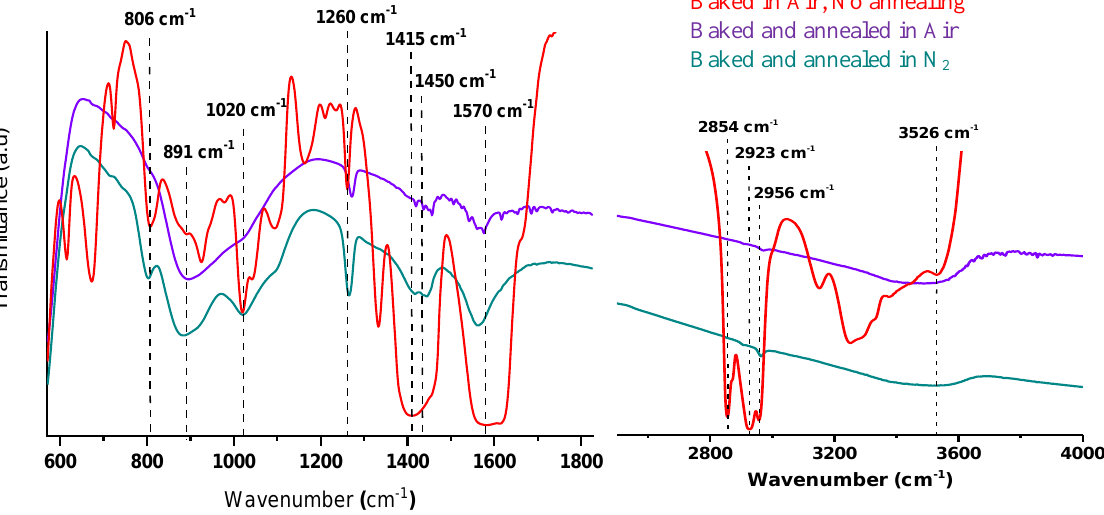
Figure 5: FTIR of ZnO nanoparticles films deposited on GaAs substrate after various processing conditions: Baked (soft annealing process) at 100 °C for 10 m in the air, baked and annealed at 350 °C for 1 hour in the air, and finally baked and annealed at 350 °C for 1 hour in nitrogen (glove